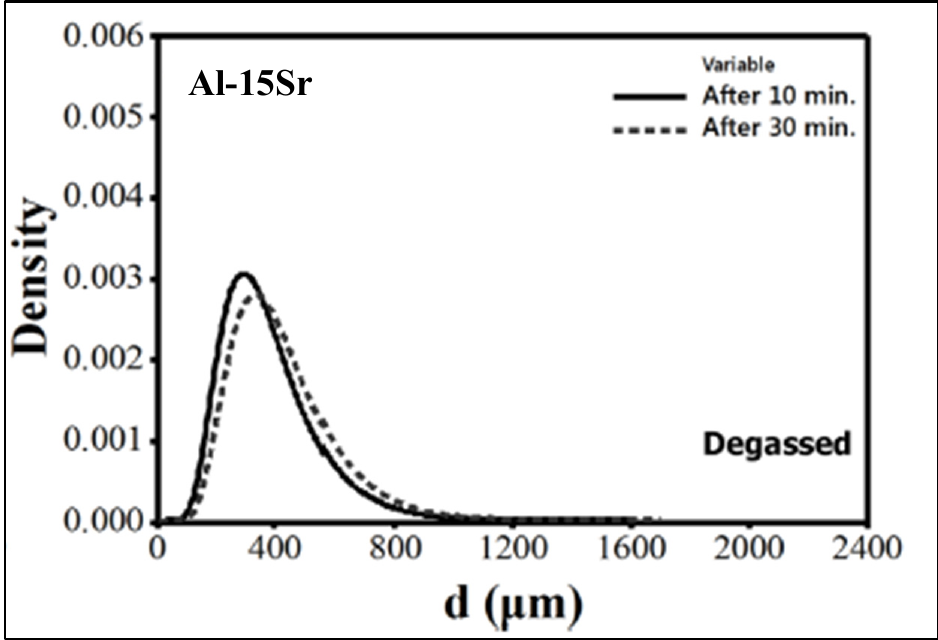
Figure 15. Lognormal distributions of pore sizes for Al-15Sr addition after 10- and 30-min holds. Tynelius et al. [26] also used the multiple regression approach to analyze their